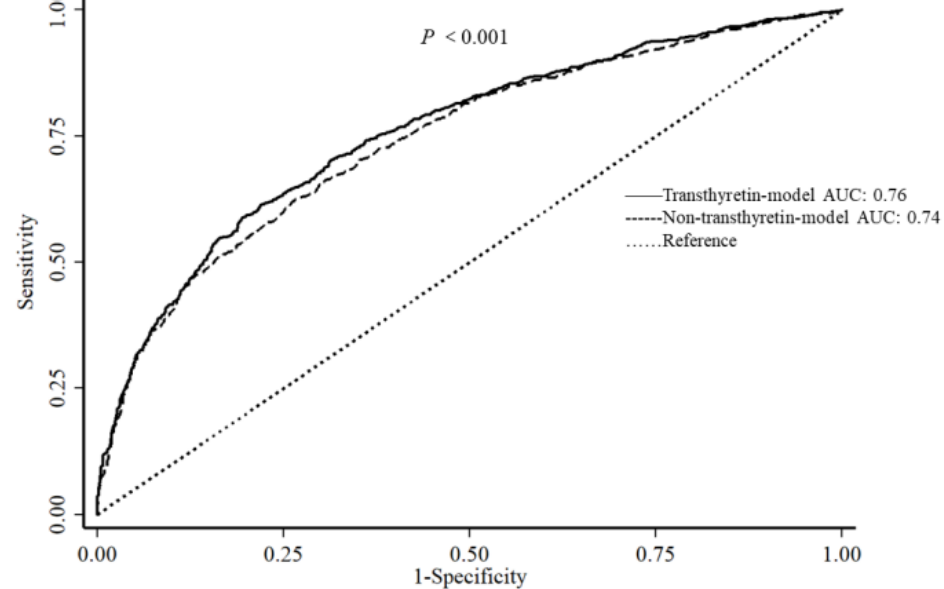
Figure 1. ROC curve of transthyretin-model and non-transthyretin-model. Abbreviations: AUC: area under the curve; ROC, receiver operating characteristic.